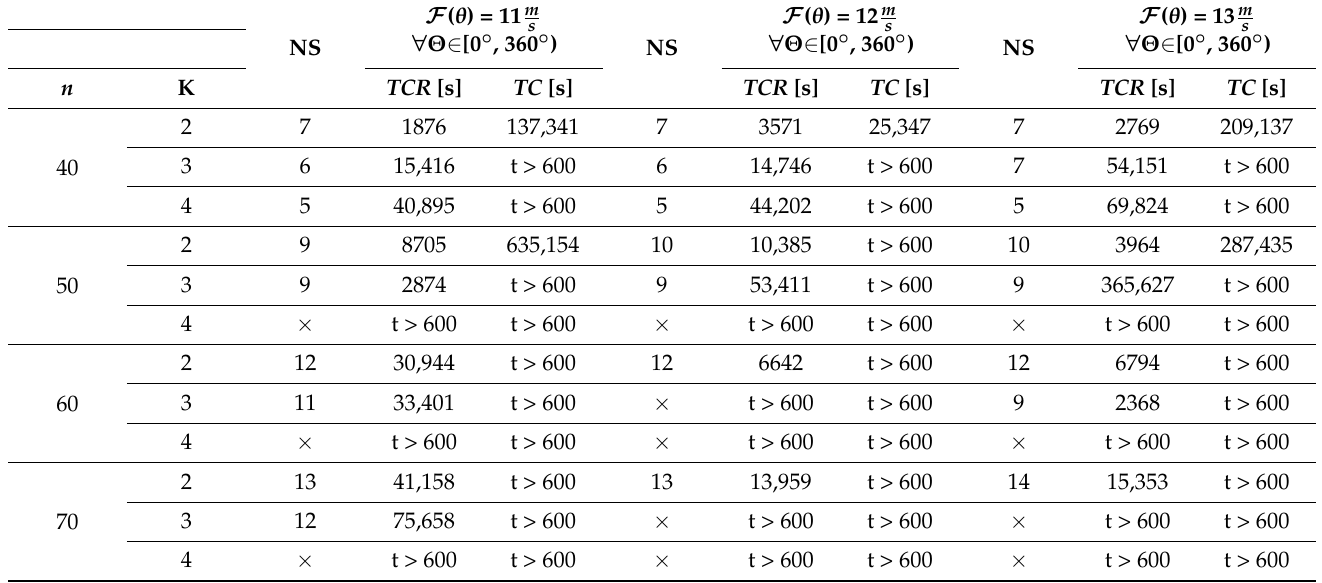
Table 1. Results of the experiments